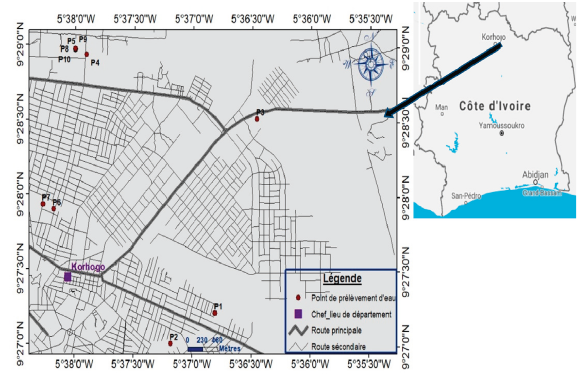
Figure 1: Sampling